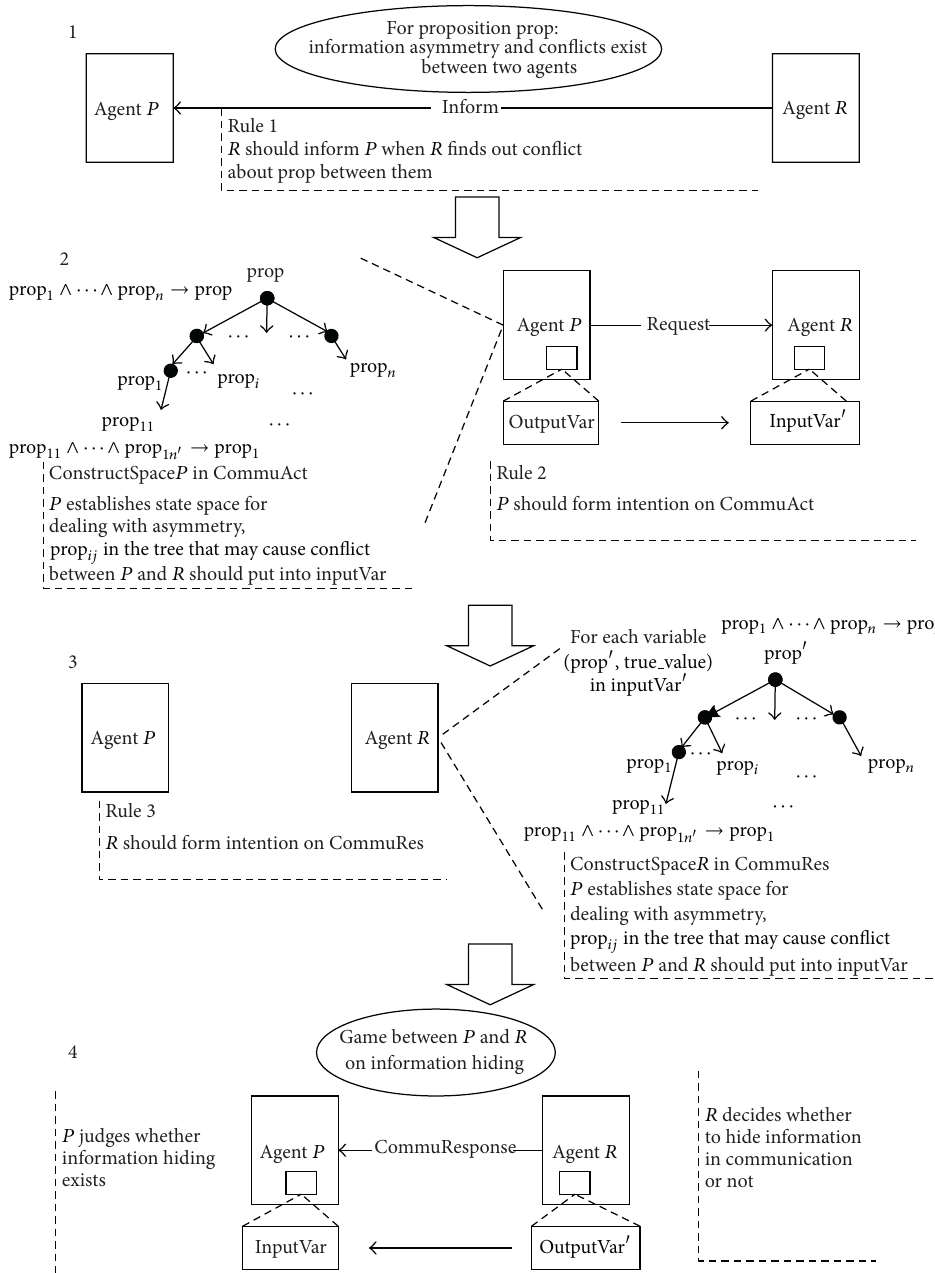
Figure 2: The framework on dealing with information asymmetry in a proactive